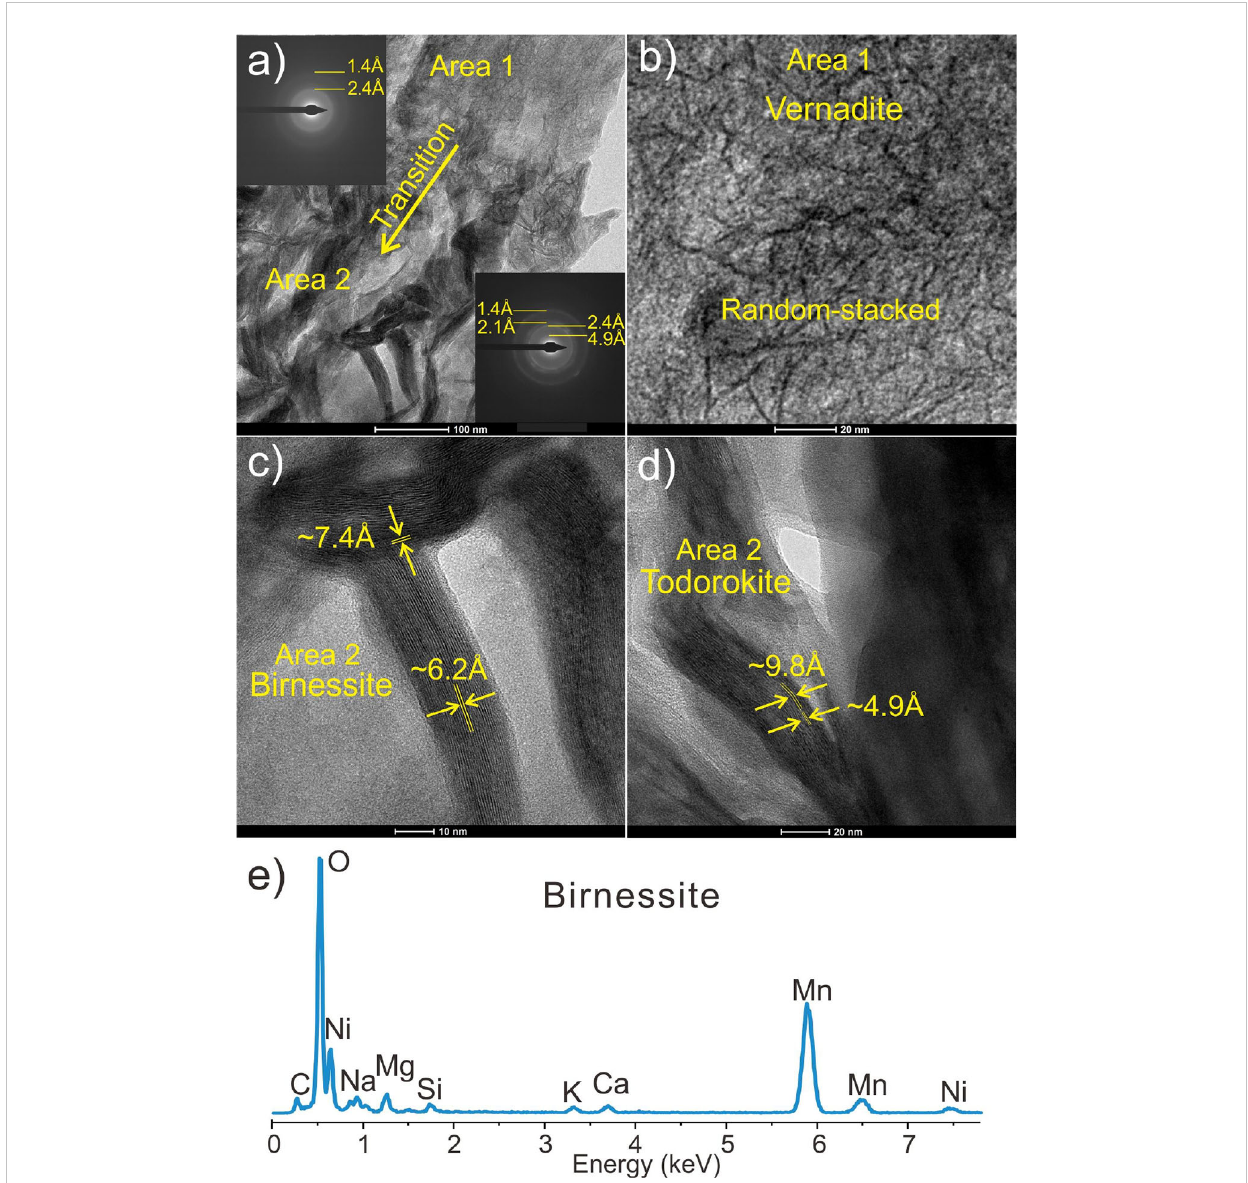
FIGURE 10 SAED patterns (A) , high resolution image (B – D) , and EDS pattern (E) of nano-minerals of sample